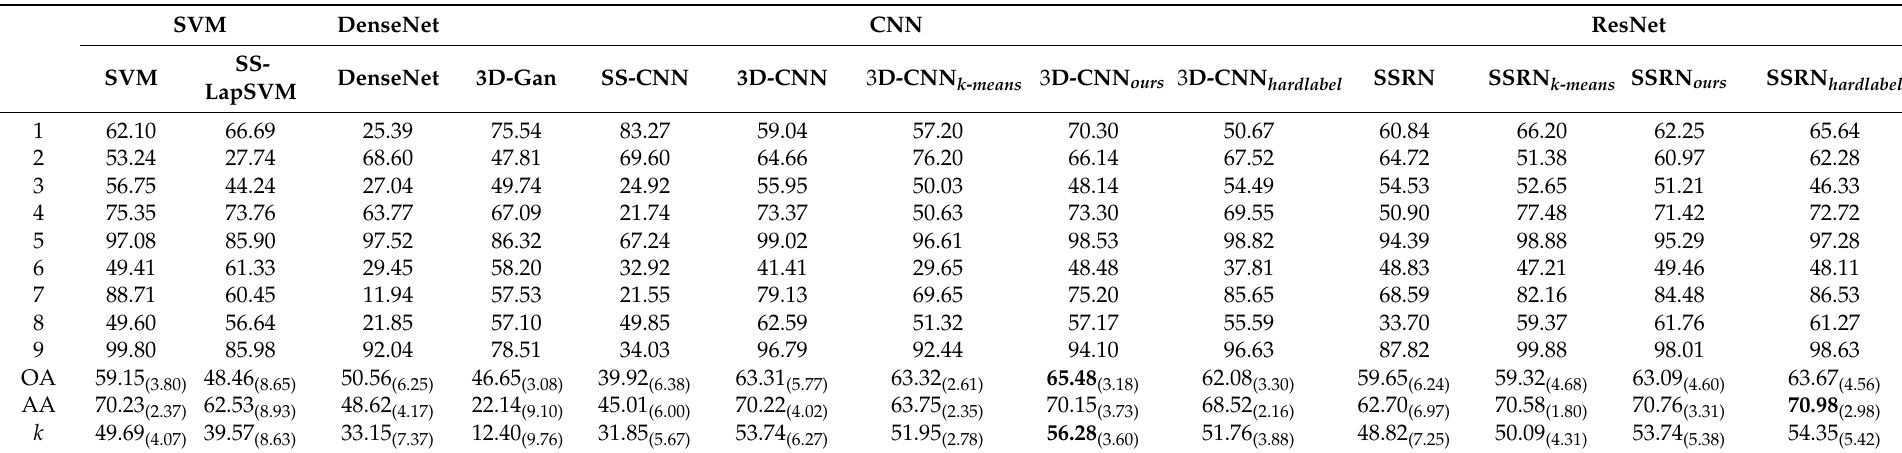
Table 2. Classification accuracy (%) for all methods with three training samples on the PaviaU dataset. Best results are in bold. The numbers in parentheses are standard variances (%).